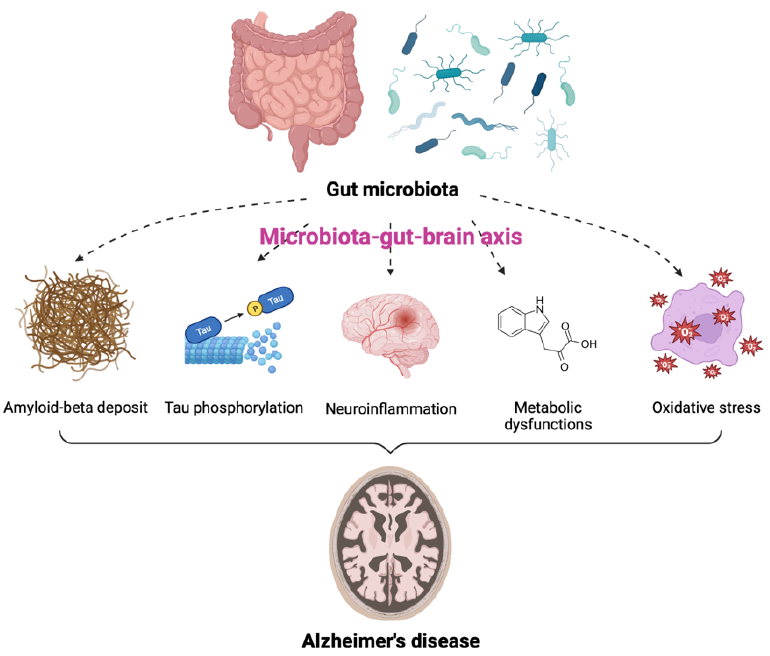
Figure 1. Contribution of gut microbiota (GM) to the pathogenesis of Alzheimer’s disease (AD). GM is involved in the onset and progression of AD through alterations of at least five pathogenic processes, including amyloid-beta deposit, increased tau phosphorylation, neuroinflammation, metabolic dysfunctions, and oxidative stress via the microbiota-gut-brain axis.